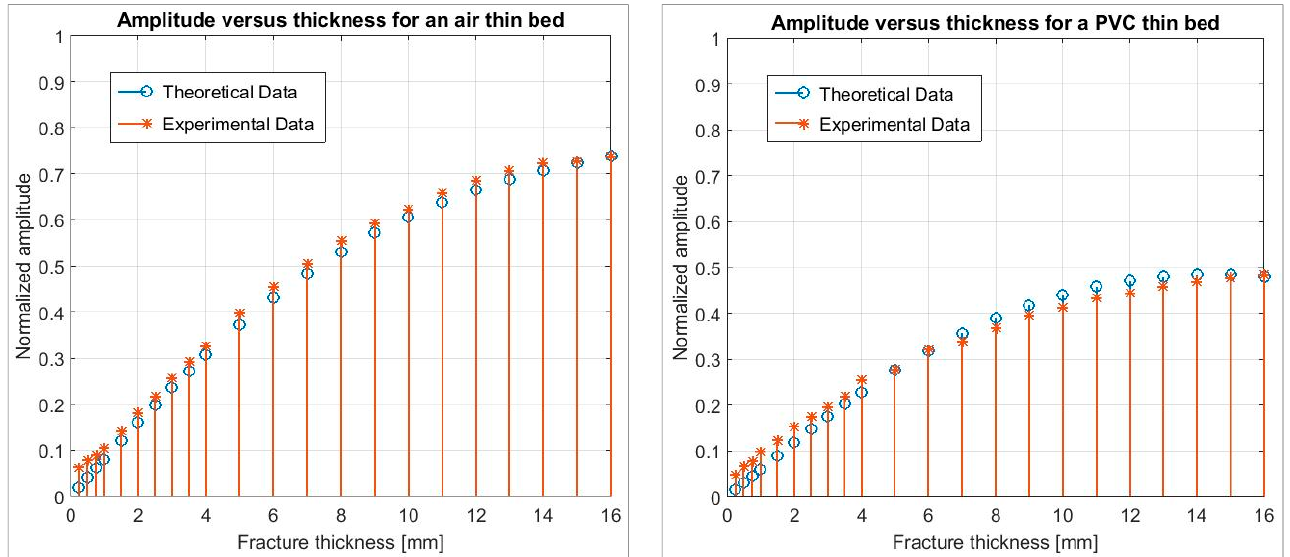
Figure 9. Amplitude versus thickness for the air-filled fractures ( left ) and the PVC-filled fractures ( right ). Stars are peak-to-peak amplitudes from laboratory tests , after rescaling. Circles are reflection coefficients calculated from the thin bed theory (Equation (1)).